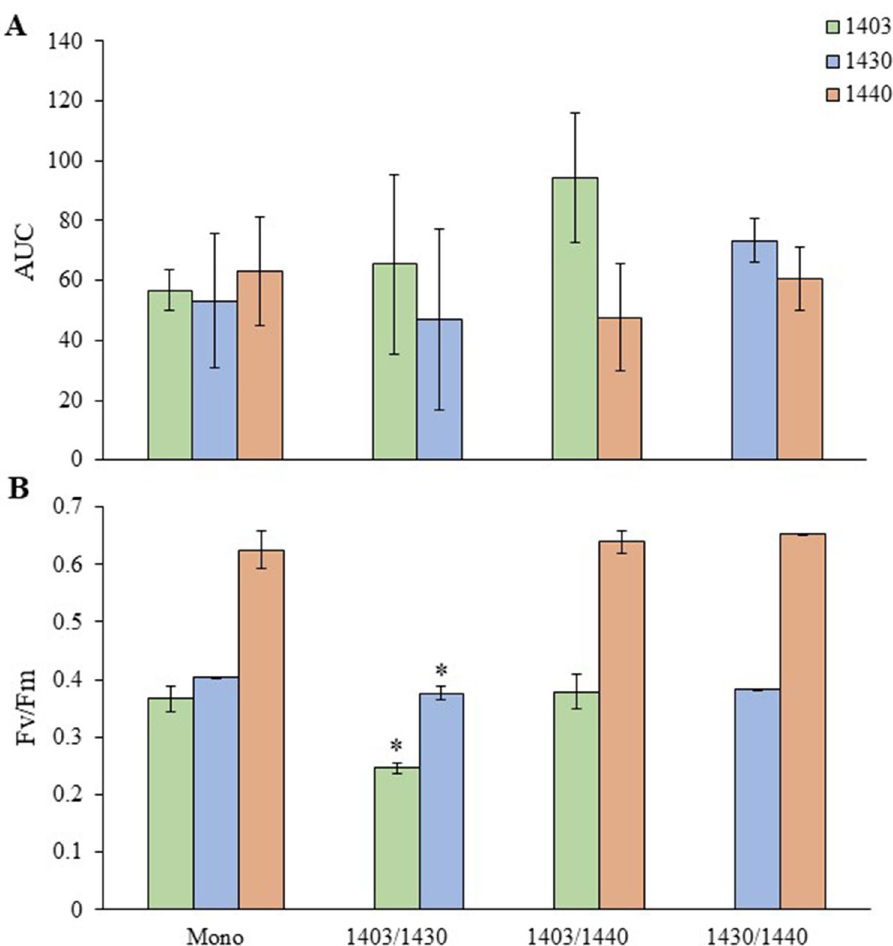
Figure 2. Growth and photosynthesis measured as ( A ), Area under the curve (AUC); and ( B ), Maximum quantum yield of PSII (Fv/Fm) for N. spumigena strains 1403, 1430, and 1440 grown as a monoculture and co-cultures (1403/1430, 1403/1440, and 1430/1440). All data are shown as mean ± standard error ( n = 3); asterisk indicates significant ( p < 0.05) difference from the monoculture of the respective strain based on the GLM output (Supplementary Table 4).